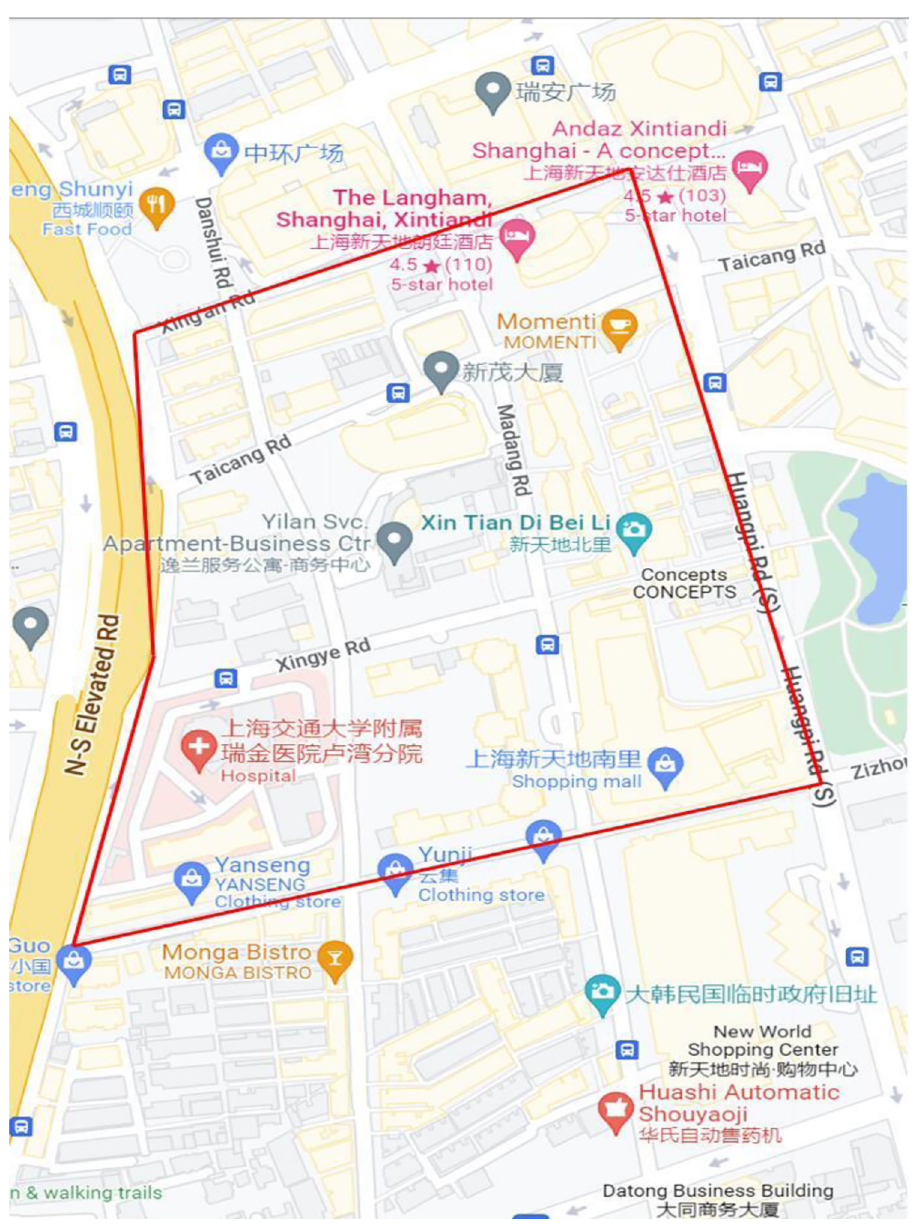
Fig 7. Location of the renovation project of Shanghai